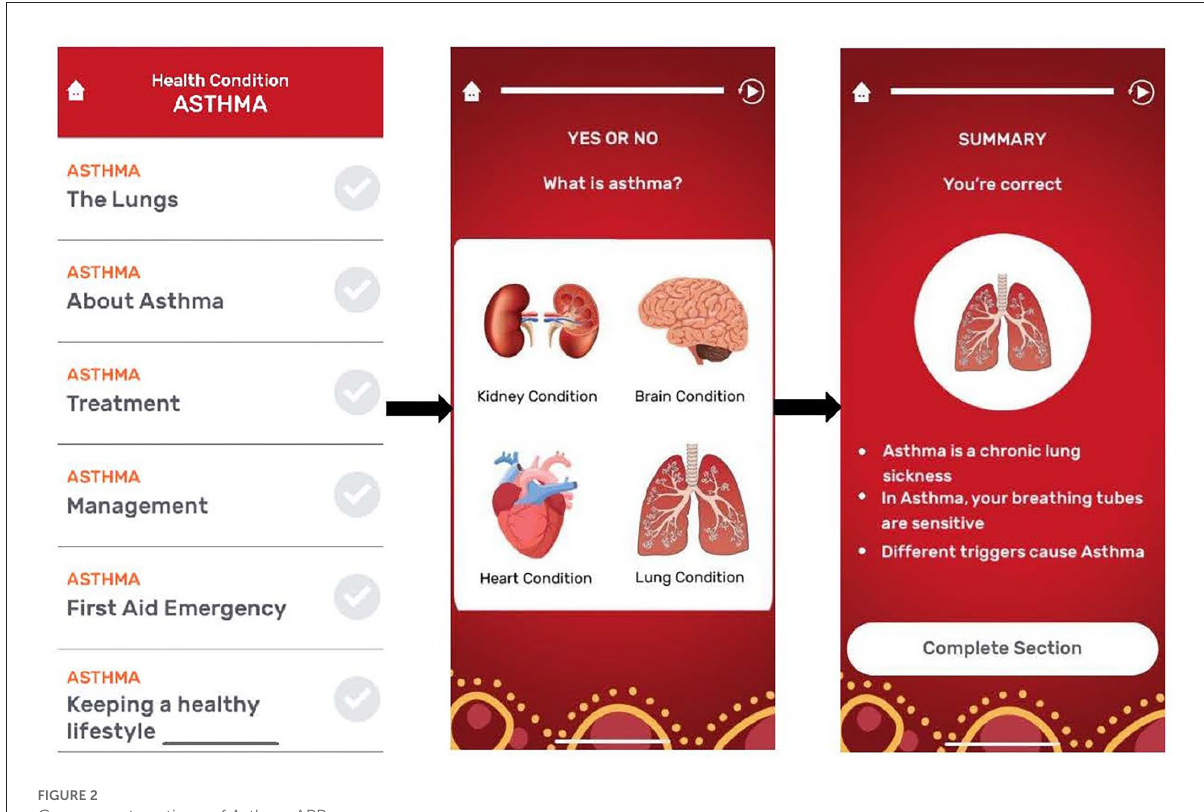
FIGURE2 Component sections of Asthma